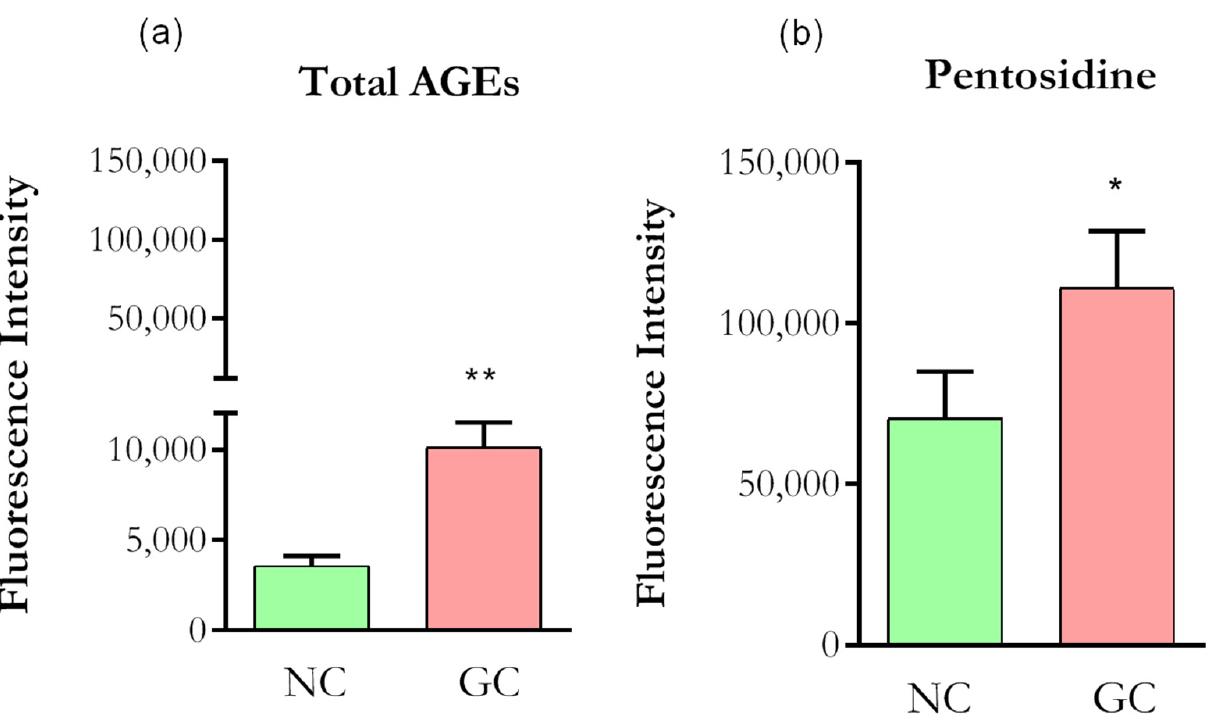
Figure 2. Autofluorescence of collagen. ( a ) Optical density (DO) values were taken from 370/440 nm for Total AGEs. ( b ) DO values were taken from 328/378 nm for Pentosidine. NC (normal collagen), GC (glycated collagen). Data were analyzed by t -test, * p < 0.01; ** p < 0.001). Five independent and similar assays were performed in